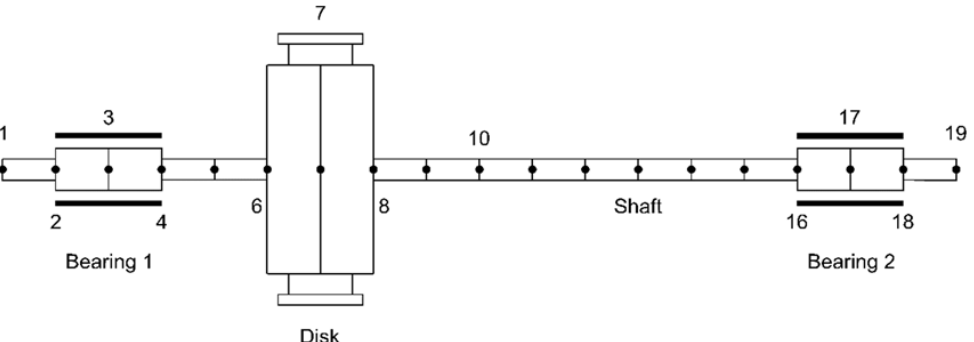
Figure 2. Sketch of the rotor used in the simulations (out of scale, for better visualization).